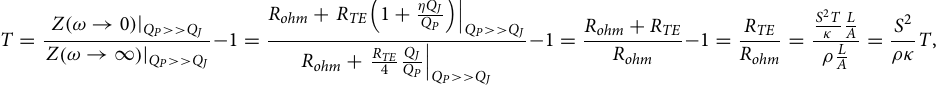
Thermoelectric materials and elements (TEs) that can convert a temperature gradient into electricity (Seebeck effect) or electricity into a temperature gradient (Peltier effect) have drawn significant attention as a key tech- nology for renewable energy 1,2 . The performance and energy efficiency of TEs at the temperature T have been described as a function of dimensionless figure of merit zT , where z (= S 2 / ρκ ) is the function of Seebeck coefficient ( S ), resistivity ( ρ ), and thermal conductivity ( κ ) 1–3 . The zT values are typically estimated using two different TEs such as a rectangular solid for the measurement of S and ρ , and a thin disk for the measurement of κ 3 ; however, the ideal estimation of the zT requires the use of the same TE or identical material. A direct zT measurement technique using a rectangular solid of the TE was proposed by Harman et al. in 1958. The Harman method 4–6 uses AC resistance R AC with an alternating current (AC) and DC resistance R DC with a direct current (DC), based on which zT is expressed as zT = R DC / R AC − 1. However, the applicability of the method is limited owing to lack of information on the frequency of the AC and suitable magnitude of the AC and DC into the TEs. Another approach to directly estimate zT using the same TE is a technique called impedance spectroscopy (IS), which uses the frequency domain based on an one-dimensional heat conduction equation 7–16 . Figure 1a,b